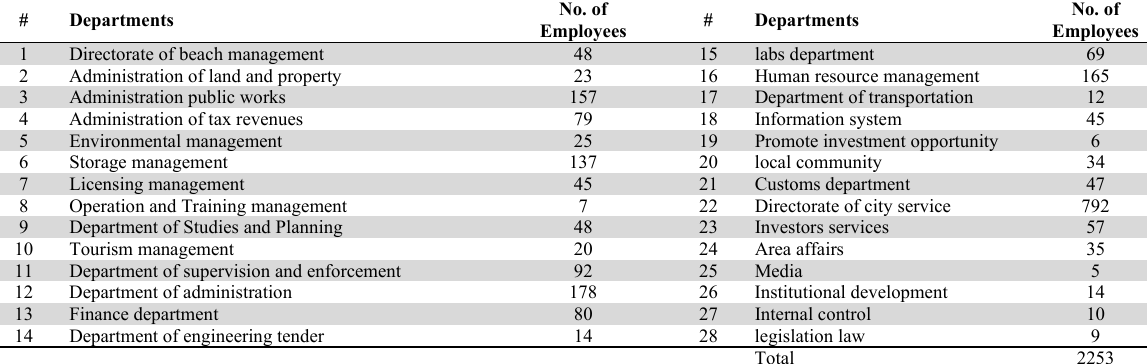
Number of employees in Aqaba Economic Zone Authority (Aqaba